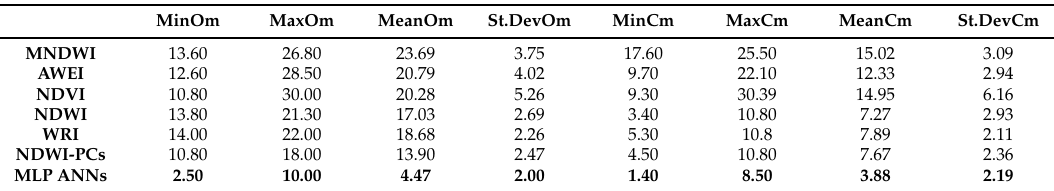
Table 1. The average values of commission and emission error (In %) achieved by different models for surface water extraction. MinOm MaxOm MeanOm St.DevOm MinCm MaxCm MeanCm St.DevCm MNDWI